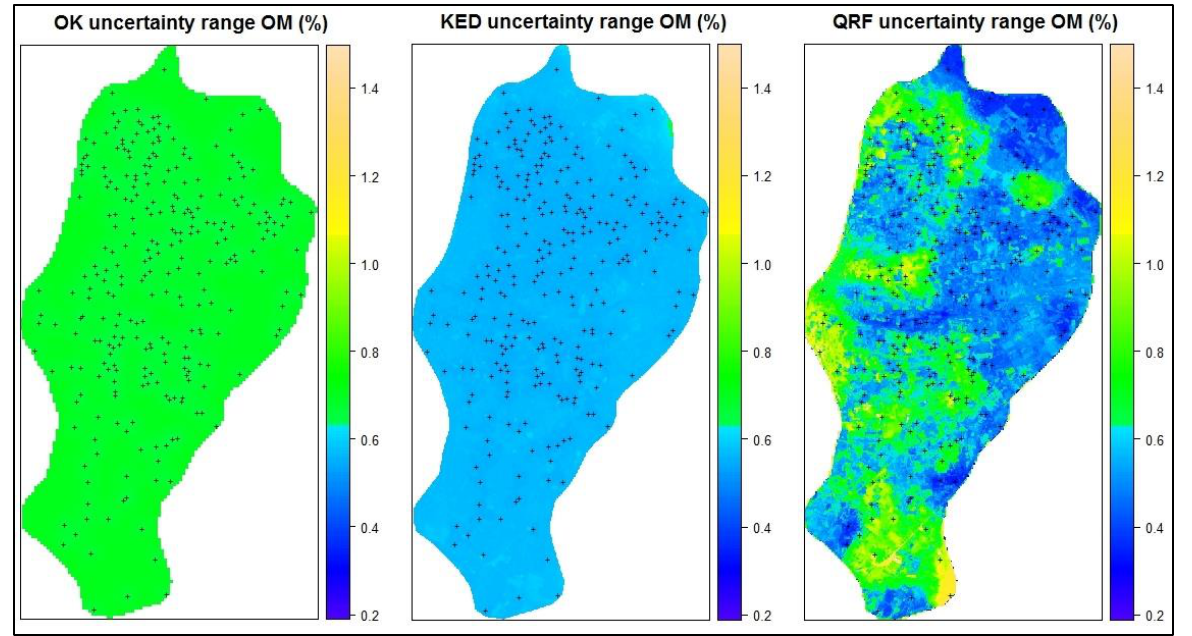
Figure 11. Uncertainty maps of soil OM.